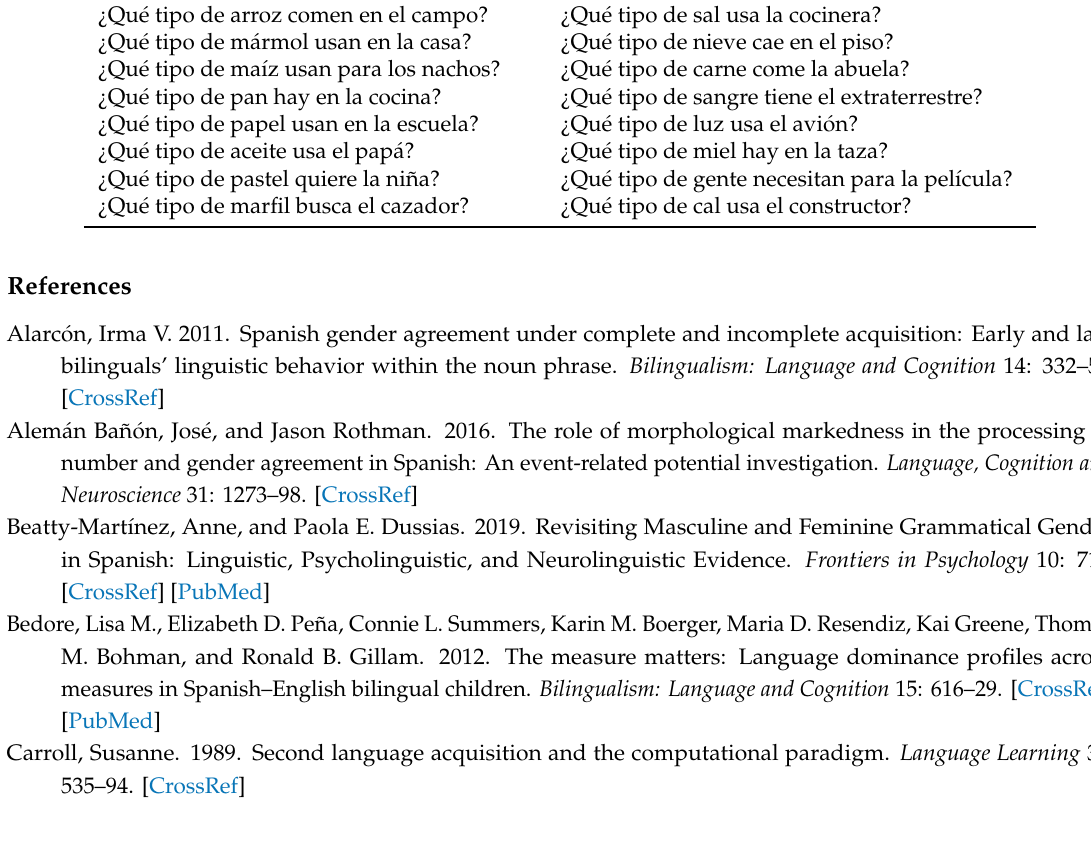
d. Feminine non-canonical